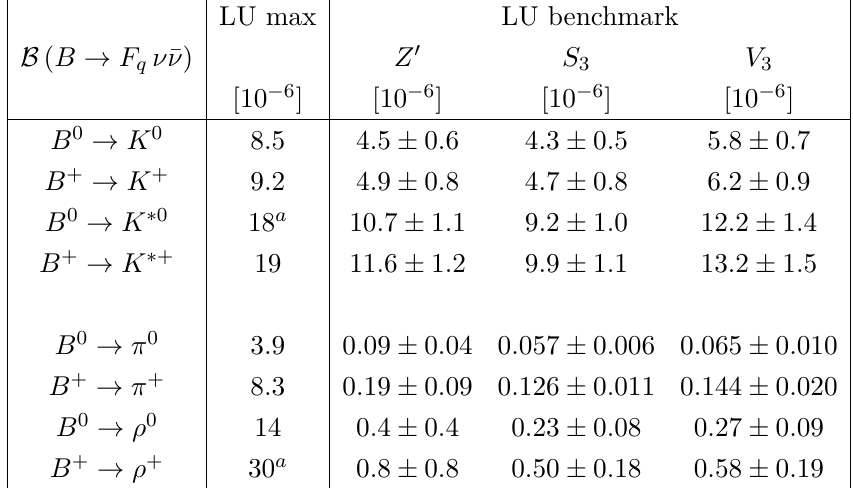
and V , for selected b → s 3 3